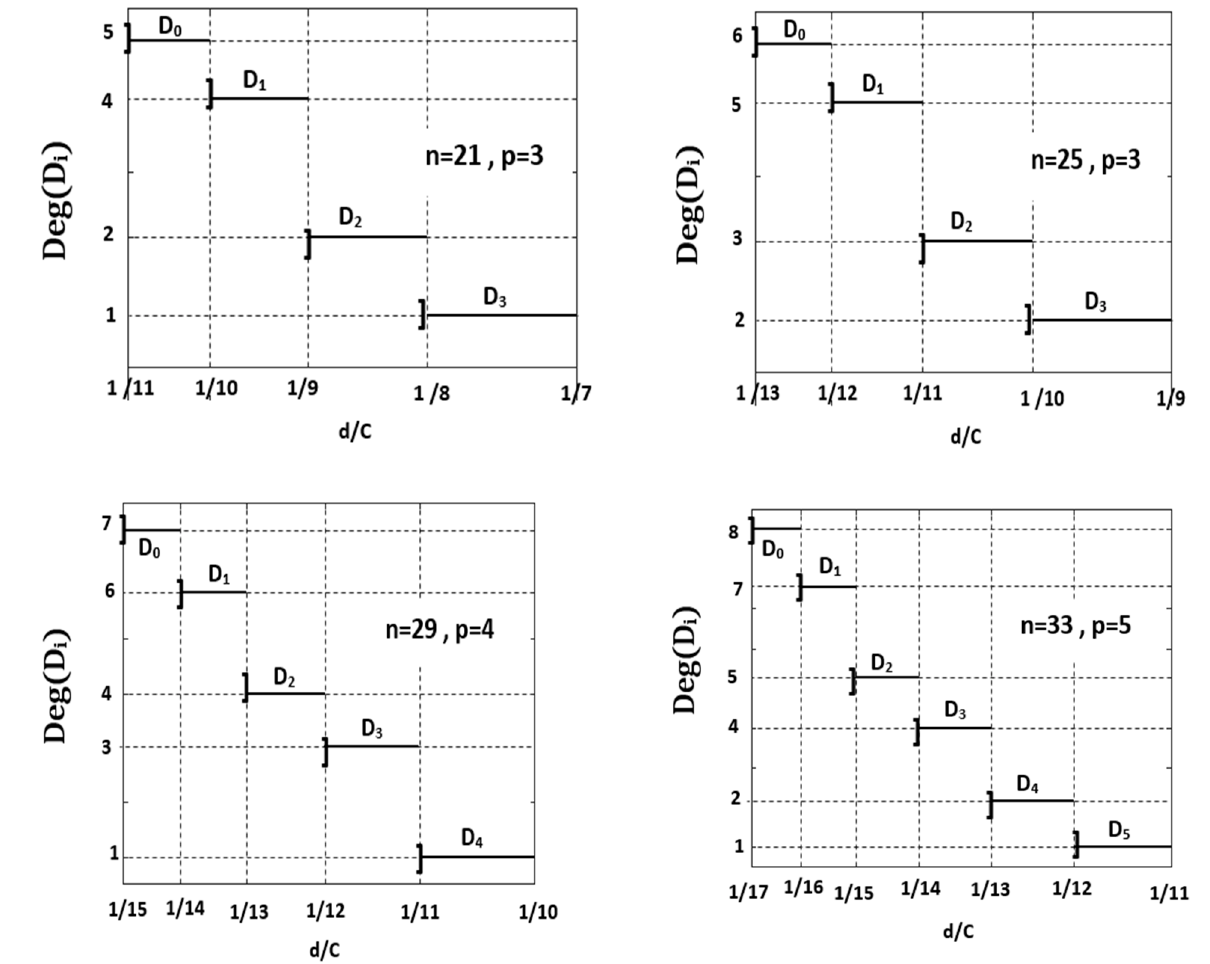
Figure A2. The variation of domain degeneracy as a function of vaccination centre demands «site needs» for selected odd values of n.